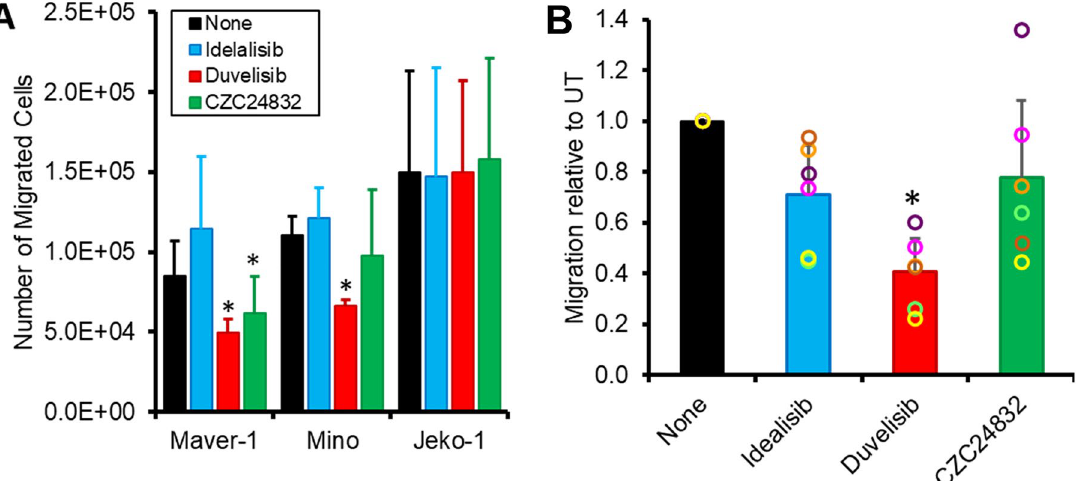
Figure 4. Inhibition of PI3Kγ reduces the motility of MCL cells. ( A ) Migration of Maver-1, Mino and Jeko-1 cell lines to CCL21 (1 µM) in the presence of the indicated inhibitors (mean ± SD of n = 3 separate experiments). ( B ) Migration of primary MCL cells to CCL21 in the presence of the indicated inhibitors (mean ± SD, n = 6 patients). Due to the variation in the number of cells migrating from the different patients’ data are normalised against migration of untreated cells to CCL21; circles represent the migration of cells from each of the individual patients (data for individual patients can be found in Supplementary Figure 4D). * P < 0.05. Statistical significance was determined using the paired Student’s T-Test; for ( B ) the test was performed on the raw